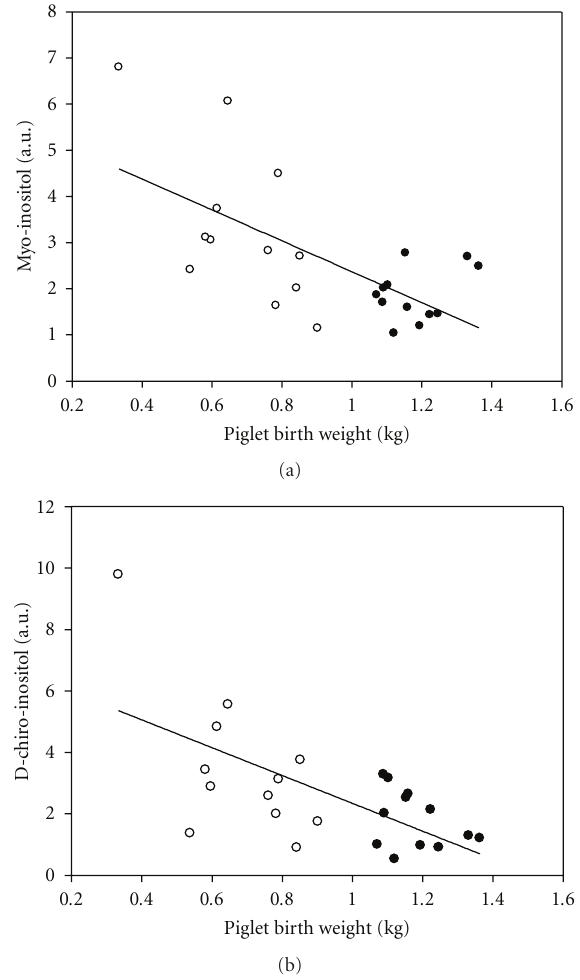
Figure 4: Relationship between piglet birth weight and (a) plasma myo-inositol and (b) plasma D-chiro-inositol. For both inositols a negative relationship (linear regression) exists between the plasma inositol concentration and piglet birth weight. R 2 = 0 . 43 for myo- inositol; R 2 = 0 . 42 for D-chiro-inositol. Each point represents a single